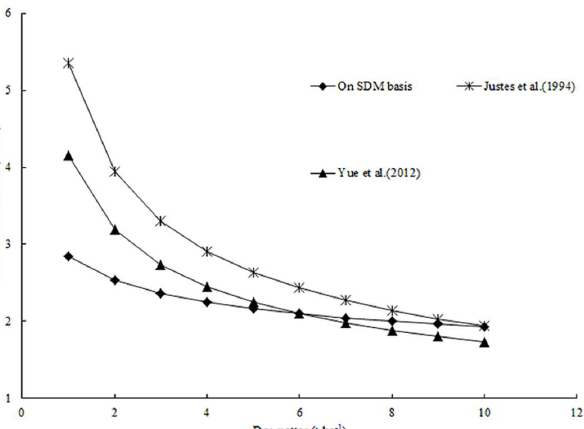
Fig 8. Comparison of different N c curves of winter wheat. The symbol * represents the N c curve of winter wheat (N c = 5.35 × DM -0.4 ) based on plant DM in France. The symbol ▲ represents the N c curve of winter wheat (N c = 4.15 × DM -0.38 ) based on plant DM in the North China Plain. The symbol ◆ represents the N c curve (N c = 2.85 × SDM -0.17 ) based on SDM in eastern